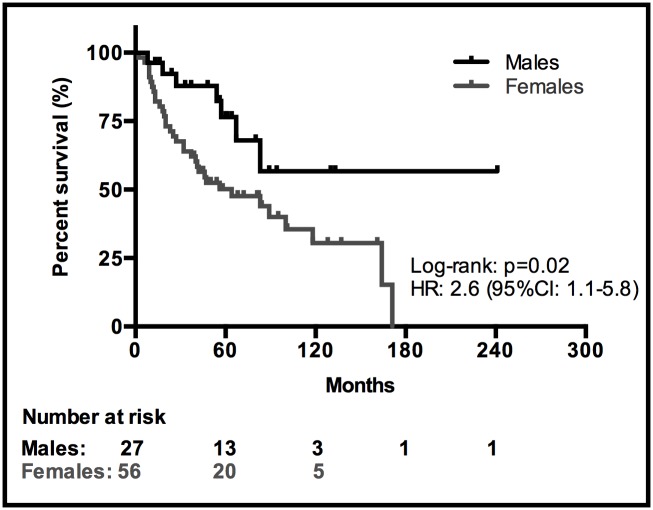
Kaplan-Meier survival curves for males vs. females.